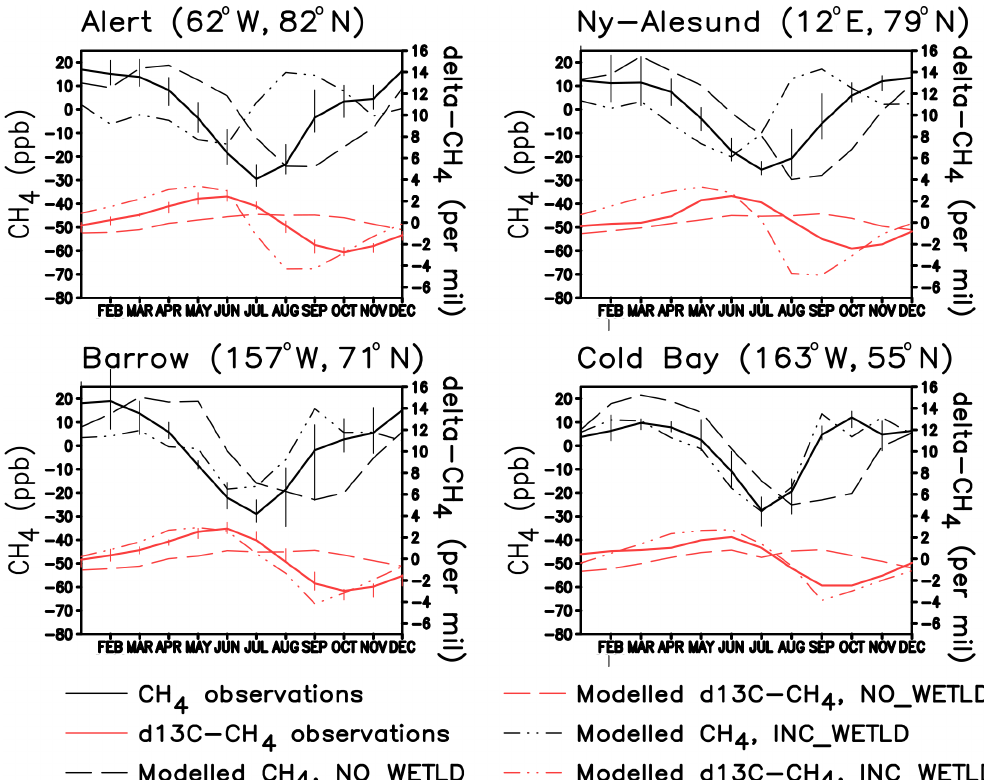
Figure 6. Modelled seasonal cycles of CH 4 and δ 13 C-CH 4 compared to NOAA-ESRL and CU-INSTAAR observations. Annual means have been subtracted from both the model and measurement data. Black represents CH 4 mole fractions, and red represents δ 13 C-CH 4 . Where there are sufficient data available in the 2005–2009 period, the range of observed monthly mean values relative to the annual mean is represented by a vertical bar. Dashed lines represent model results from the NO_WETLD scenario (where wetland emissions >50 ◦ N have been removed relative to BASE). Dot-dot-dash lines represent model results from the INC_WETLD scenario (where wetland emissions >50 ◦ N have been increased by 50% relative to BASE). Variations in δ 13 C-CH 4 have been multiplied by a factor of